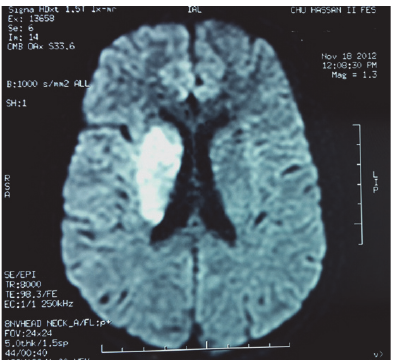
Figure 1: MRI Echo-Planar Imaging (EPI) sequence showing a right middle cerebral infarction.